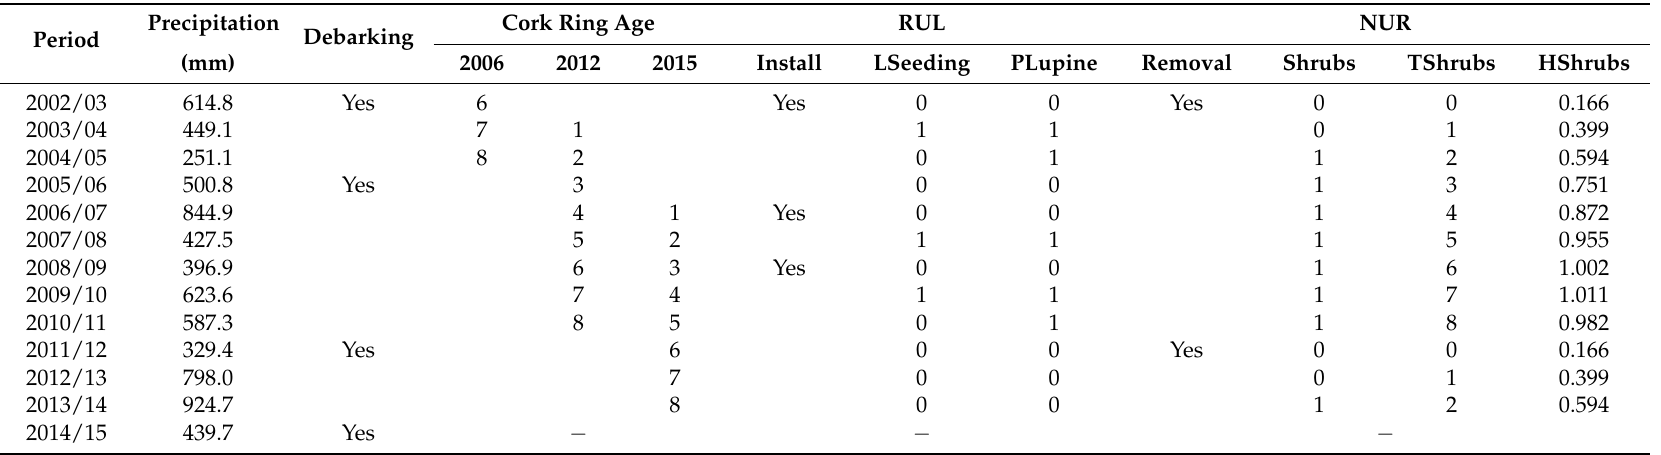
Table 1. Yearly operations calendar carried out for each understory management alternative. with corresponding annual precipitation, computed from October of the year before the growth period to September of the growth period year, shrubs height (HShrubs) estimation with equation 3, and cork ring ages for each cork year sampling. RUL represents the understory removal followed by lupine seeding and NUR represents the maintenance of spontaneous understory